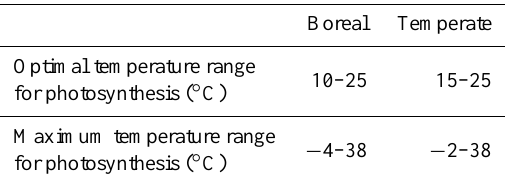
Table D2. Climatic range parameters. The affiliations to species are shown in Table D3.